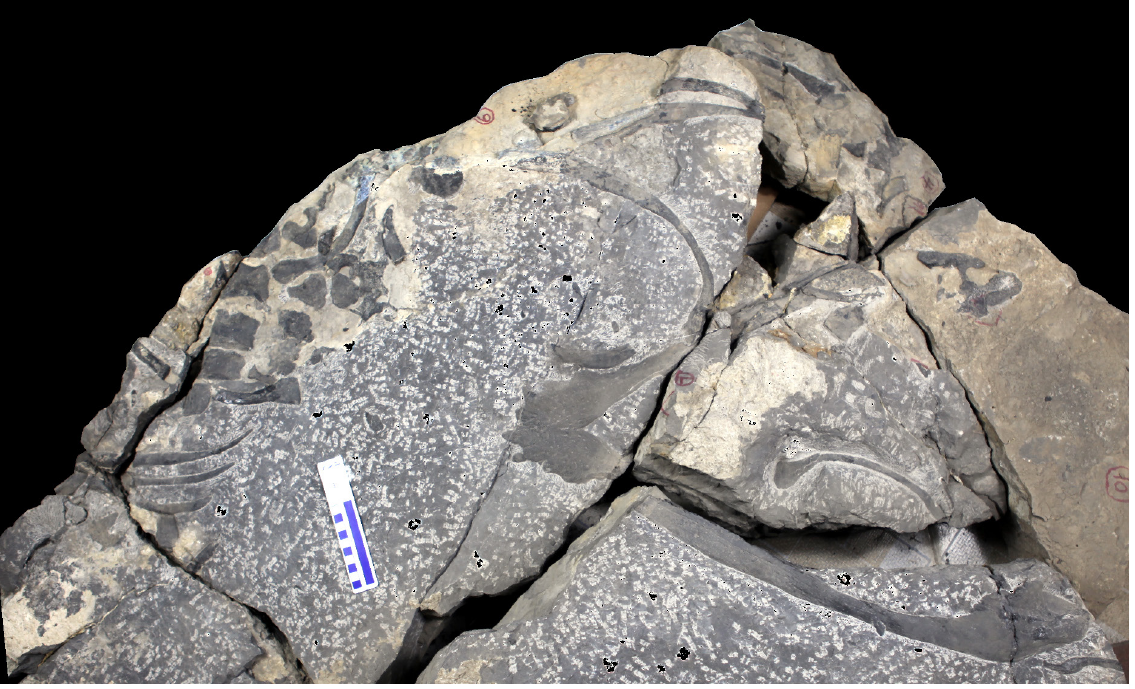
Figure 8. Holotype of Nothosaurus zhangi (LPV 20167), partial skeleton showing vertebrae and ribs (top) and the paired den- taries (middle right). Photograph by